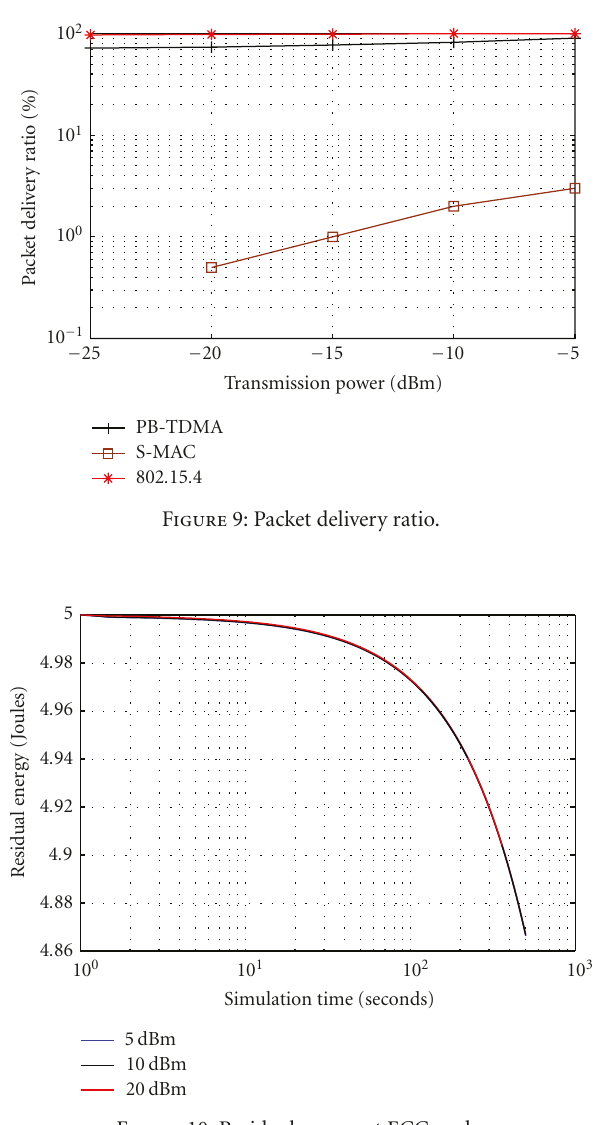
Figure 10: Residual energy at ECG